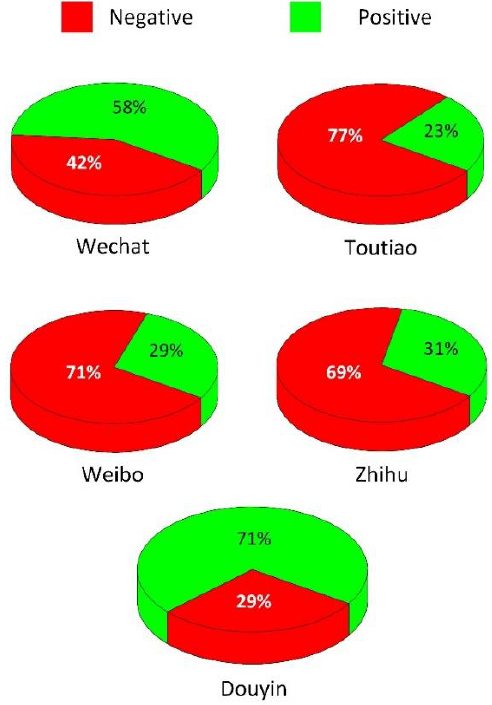
Figure 8. Sentiment trends in social media apps.